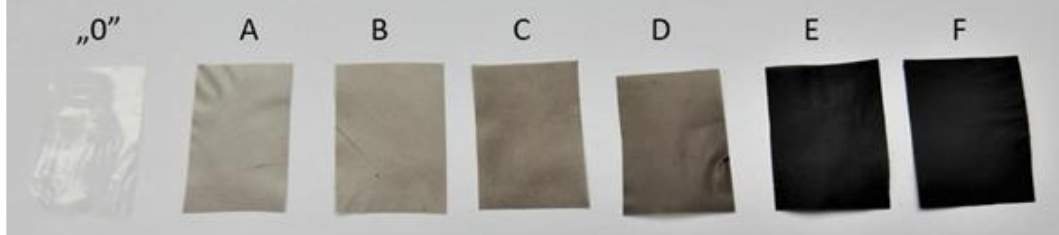
Figure 15. Images of a pure cellulose membrane ( “ 0 ” ) and GO/CEL composite membranes (A — 0.1% GO, B — 0.2% GO, C — 1% GO, D — 2% GO, E — 10% GO, F — 20% GO).